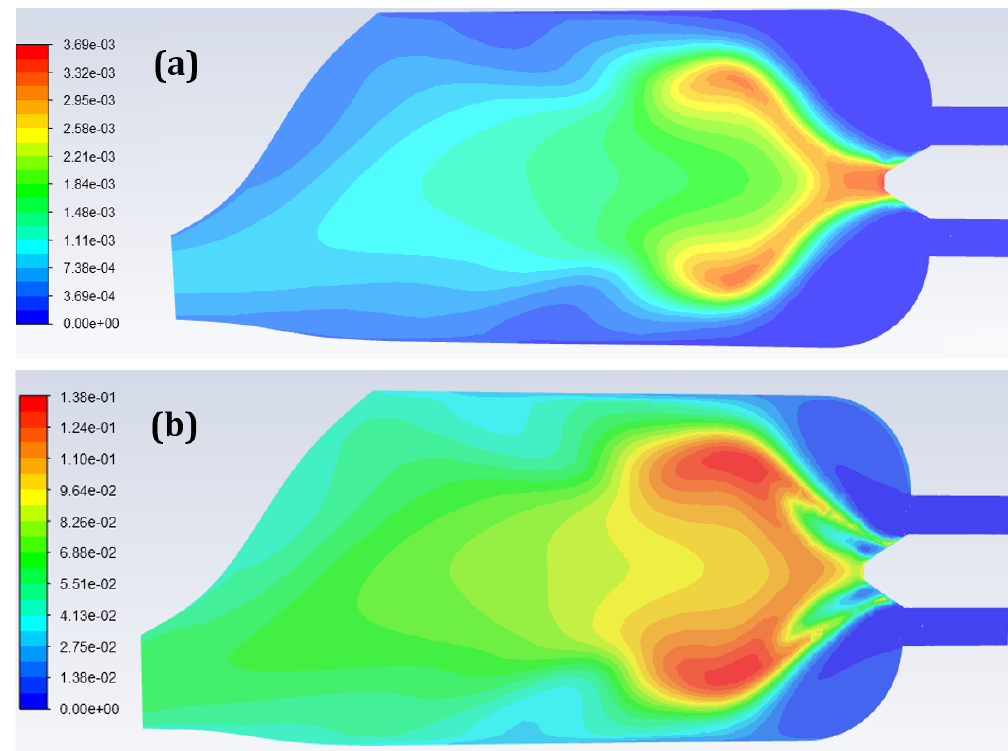
Figure 8. The species distribution, ( a ) NO X and ( b ) CO 2 , at the symmetry plane of the combustion chamber using ANSYS kerosene surrogate (C 12 H 23 ).